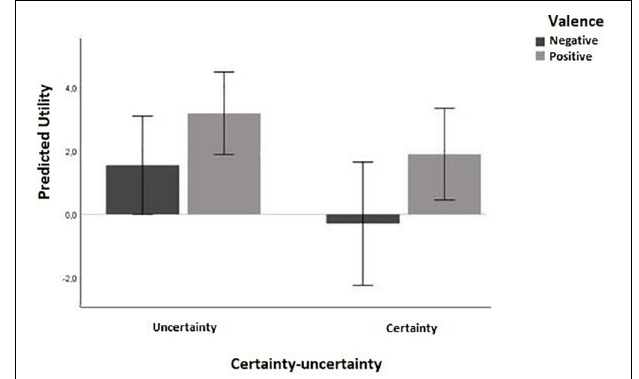
FIGURE 2 | Predicted utility decreases for certainty emotions, for both positive (happiness, hope) and negative (anger, fear) valence.